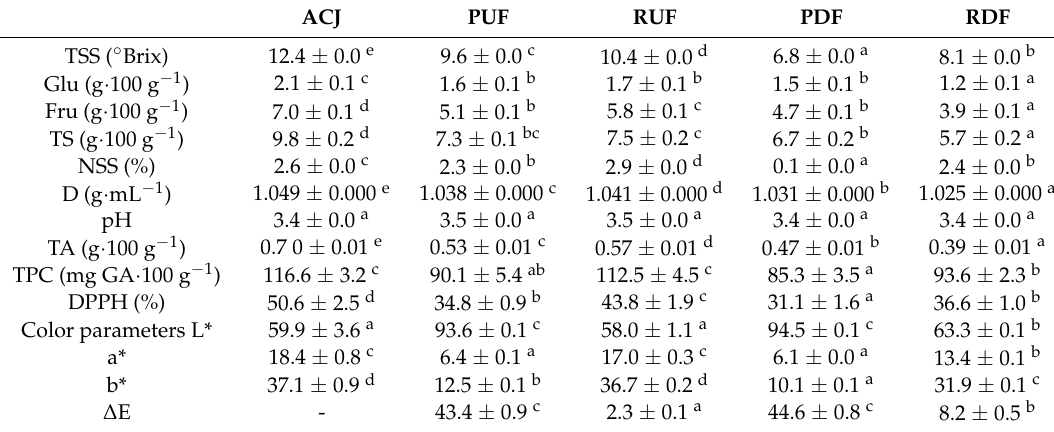
Table 1. Total soluble solids (TSS), glucose (Glu), fructose (Fru), total sugars (TS), non-sugar soluble solids (NSS), density (D), pH, total acidity (TA), total polyphenols (TPC), DPPH antioxidant activity (DPPH) of apple-cranberry cloudy juice before (ACJ) and after membrane treatment: permeate after UF (PUF), retentate after UF (RUF), permeate after DF (PDF), retentate after DF